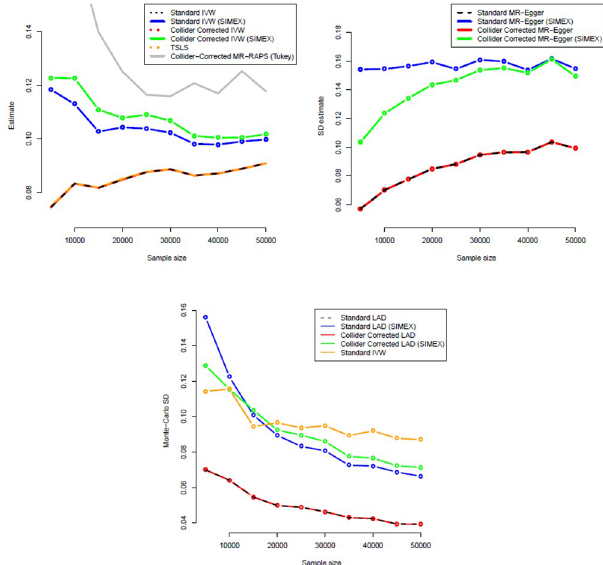
correction, with the SIMEX adjusted Collider-Corrected estimate being least biased. In Fig 11 we show how dilution in the Collider-Corrected slope estimate d b (cid:0) b � for MR-Egger can be accurately quantified using the I 2 statistic, just as the F -statistic predicts the dilution for IVW. GX This explains why SIMEX adjustment works.